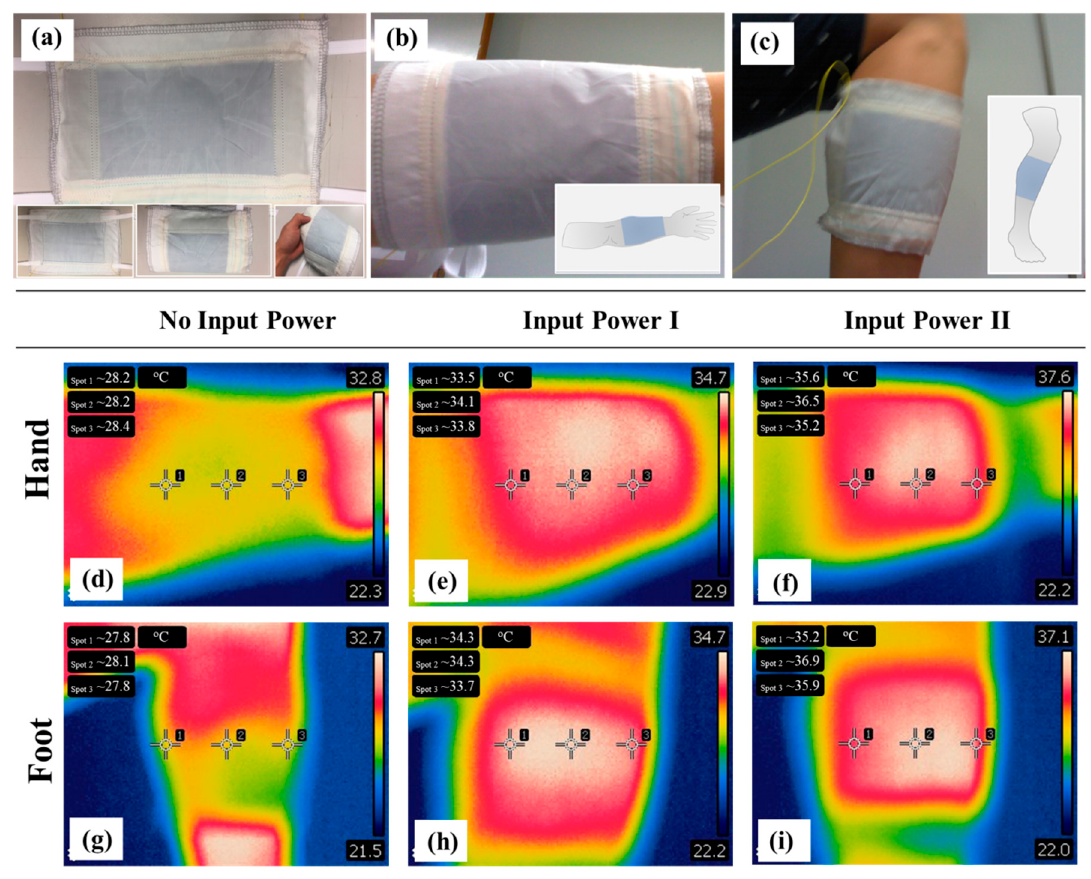
Figure 4. ( a ) Different digital photographs of modified fabric-based ETs after well sewing, and their wearable applications as ( b ) arm warmer and ( c ) leg warmer, respectively. Thermal images of arm warmer applied with an input power of ( d ) 0 W, ( e ) 1.5 W, and ( f ) 1.8 W, respectively. Thermal images of the leg warmer applied with an input power of ( d ) 0 W, ( e ) 1.5 w, and ( f ) 1.8 W, respectively.